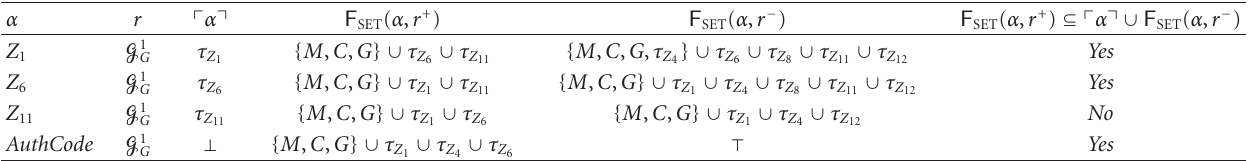
Table 20: SET analysis: role of G WLMV:prot.